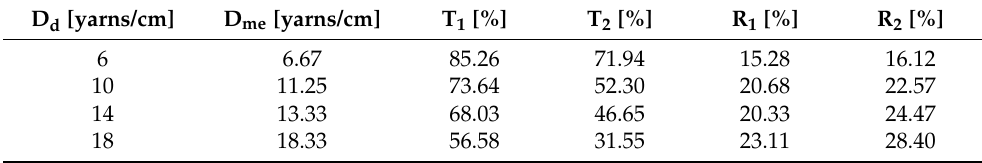
Table 7. D d and D me , values of the T (%) and R (%), for single- (T 1 , R 1 ) and double- (T 2 , R 2 ) layered PET samples.